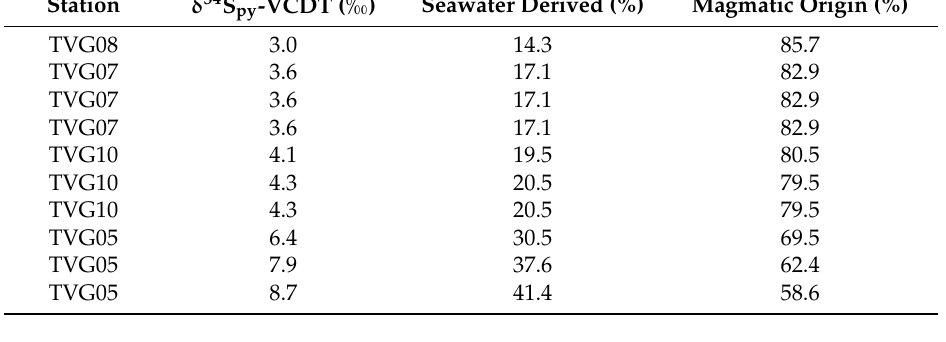
Table 6. The results of bulk sulfur isotope analysis and proportions of sulfur sources of the Wocan-1 and Wocan-2 sediments.